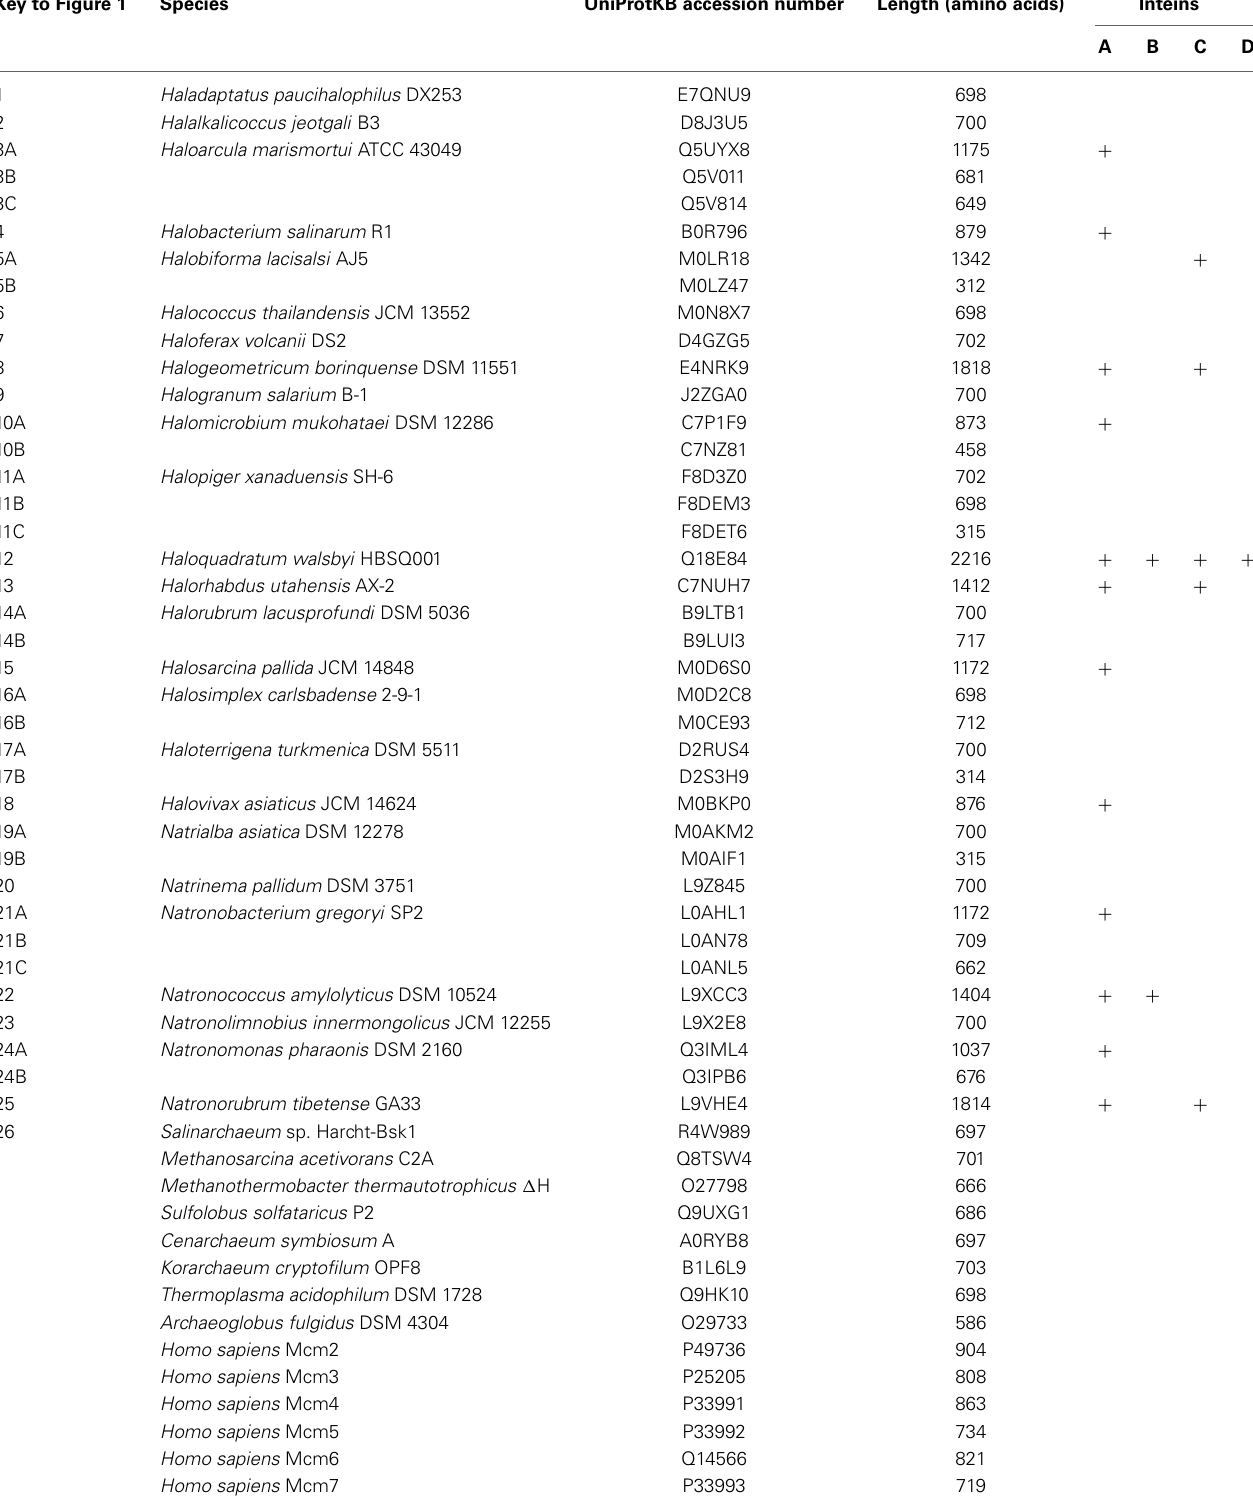
Table 1 | List of MCM proteins analyzed in this